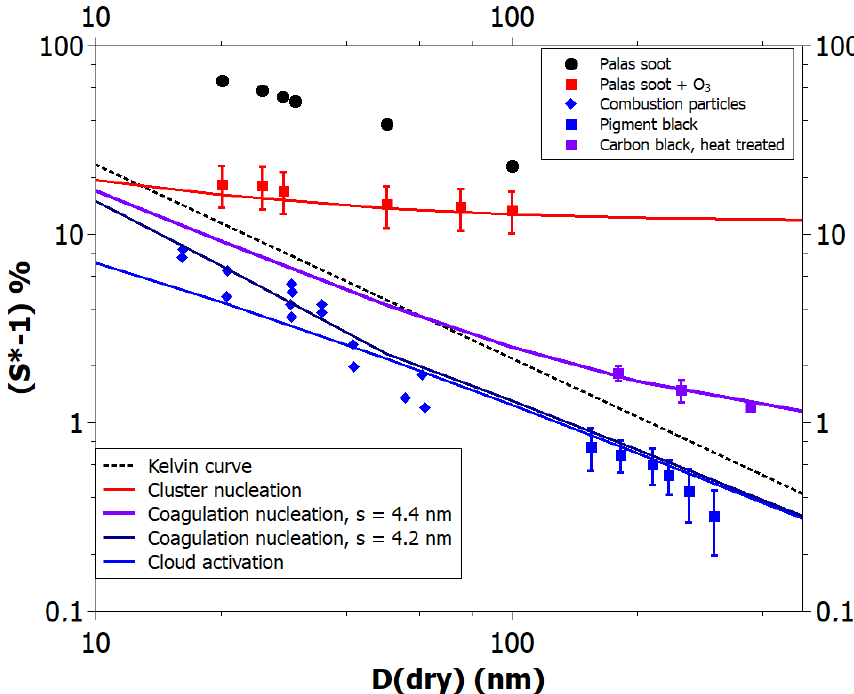
Figure 4. Experimental (markers) and theoretical (lines) critical supersaturations as a function of particle size for the cloud drop activation of hydrophobic and hydrophilic soot particles. See text for